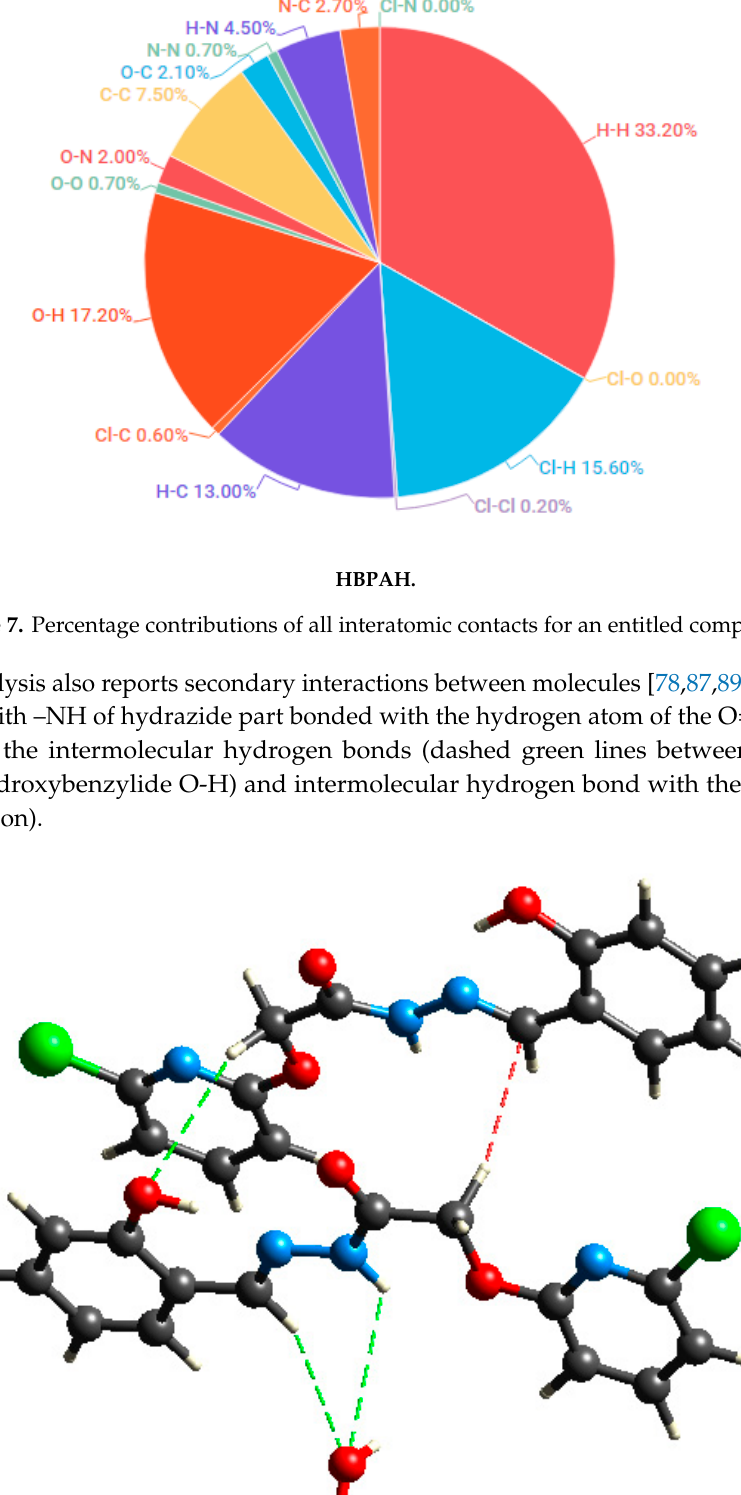
Figure 8. Hydrogen bonds in HBPAH.